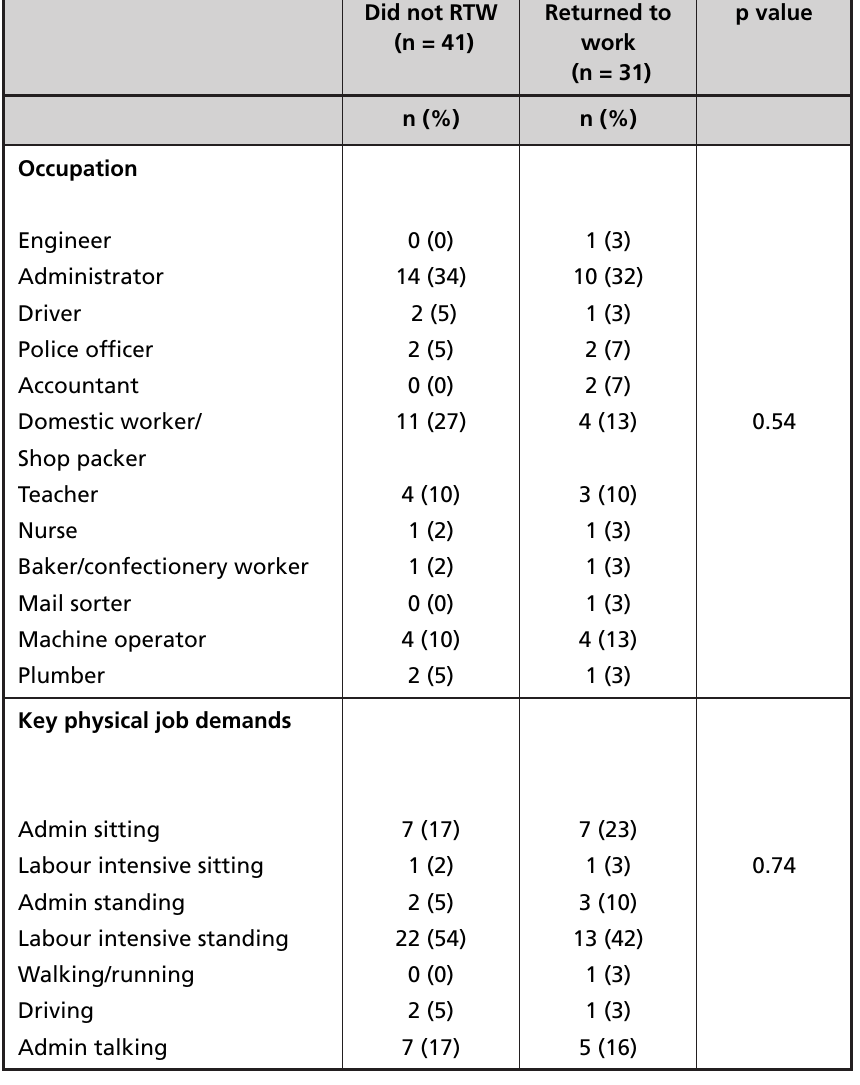
Table 2: Occupations and key physical job demands of stroke survivors who returned work and those who did not RTW at six months follow-up (n = 72)